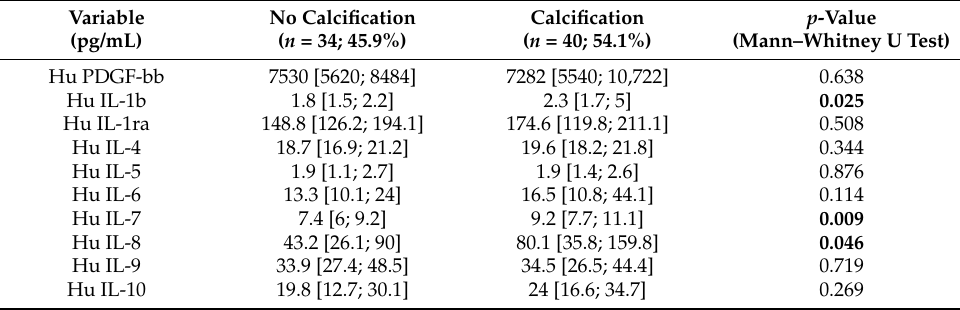
Table 2. Cytokines extended panel and calcification